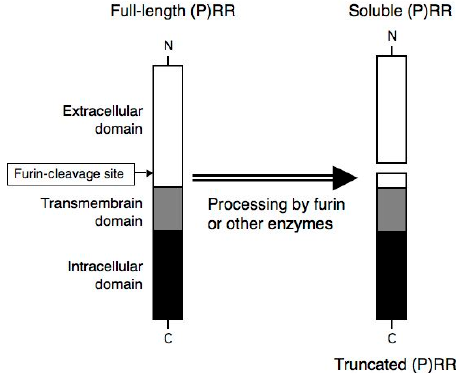
Figure 1. Schematic representation of three molecular forms of (P)RR. Full-length (P)RR consists of extracellular, transmembrane, and intracellular domains. C and N indicate C-terminal and N-terminal of (P)RR protein, respectively. Soluble (P)RR (s(P)RR) and truncated (P)RR are generated from full-length (P)RR by furin cleavage. Other possible processing enzymes to generate s(P)RR include ADAM19 and site-1 protease.